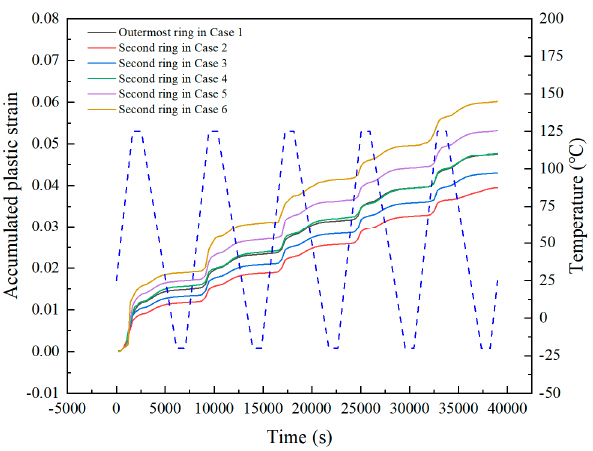
Figure 9. Comparison of accumulated equivalent plastic strain of solder joints on outermost ring in case 1 and second ring in cases 2–6.